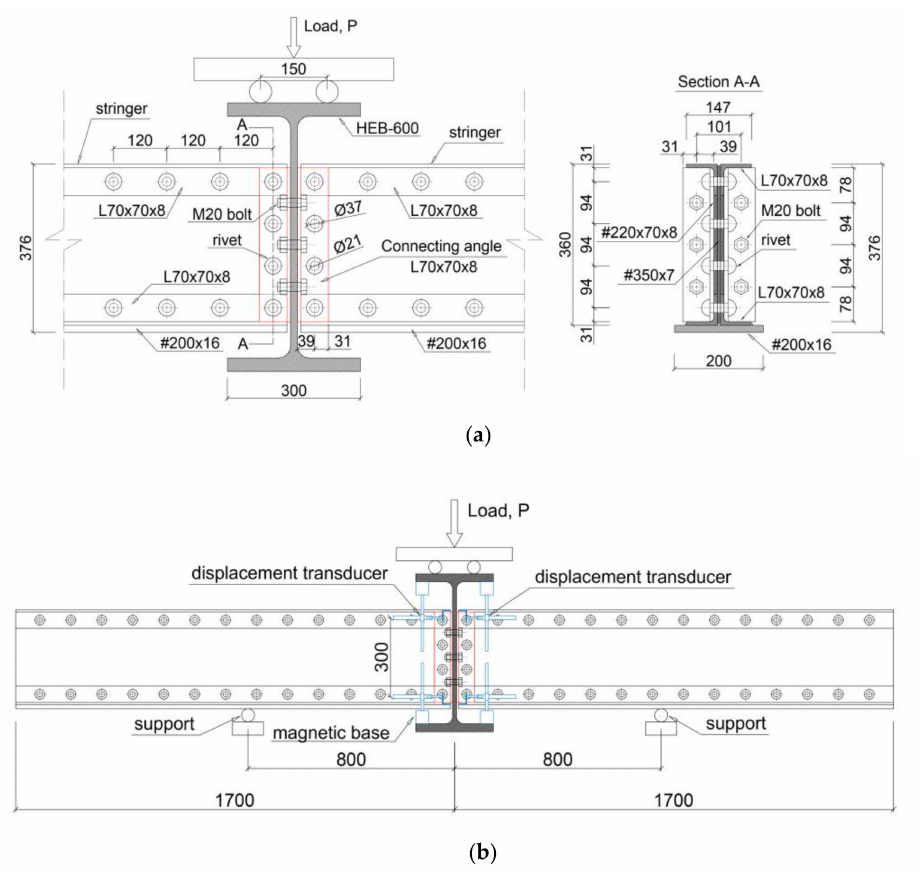
Figure 6. Sketches of the tested connections with original stringers from Redondela bridge (all dimensions in mm). ( a ) Details of the connection. ( b ) Test